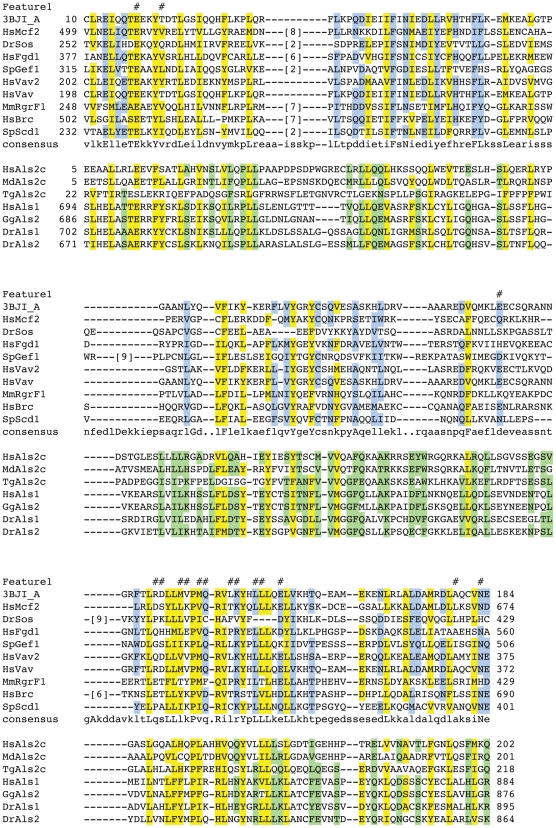
Multiple sequence alignment of the Als2cL family with the RhoGEF domain family.Residues that are conserved between the two families are highlighted in yellow, those found in only one of them are highlighted in blue and green, respectively. Essential, functional residues retrieved from the CD database are indicated by hash keys. Accession numbers of sequences can be found in Supplemental Table S7.